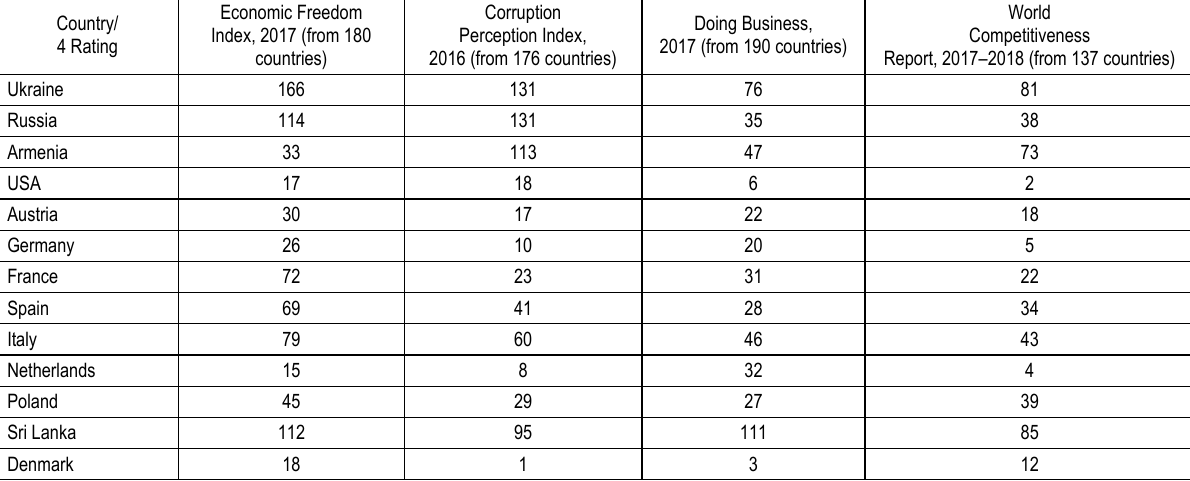
Table 2. Ukraine’ s place in world rankings relative to countries with market and transition economies Country/ 4